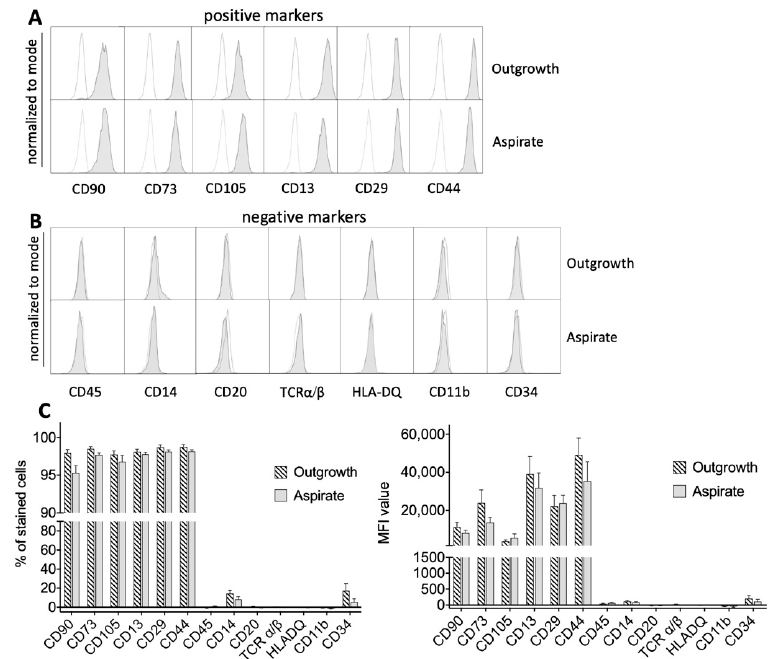
Figure 2. Expression of MSC surface markers defined by the International Society for Cellular Therapy (ISCT). ( A ) Both cells from aspirate and outgrowth cultures expressed ISCT MSC markers such as CD90, CD73, CD105, CD13, CD29 and CD44 without significant differences in expression levels (gray histograms). White histograms represent controls. ( B ) There was no significant difference for negatively expressed MSC markers defined by ISCT. ( C ) In correspondence with the previous findings, there were no significant differences between both groups regarding the percentage of stained cells for each marker or the corresponding mean fluorescence intensity (MFI) value, respectively. Only CD14 and CD34 showed a somewhat elevated expression